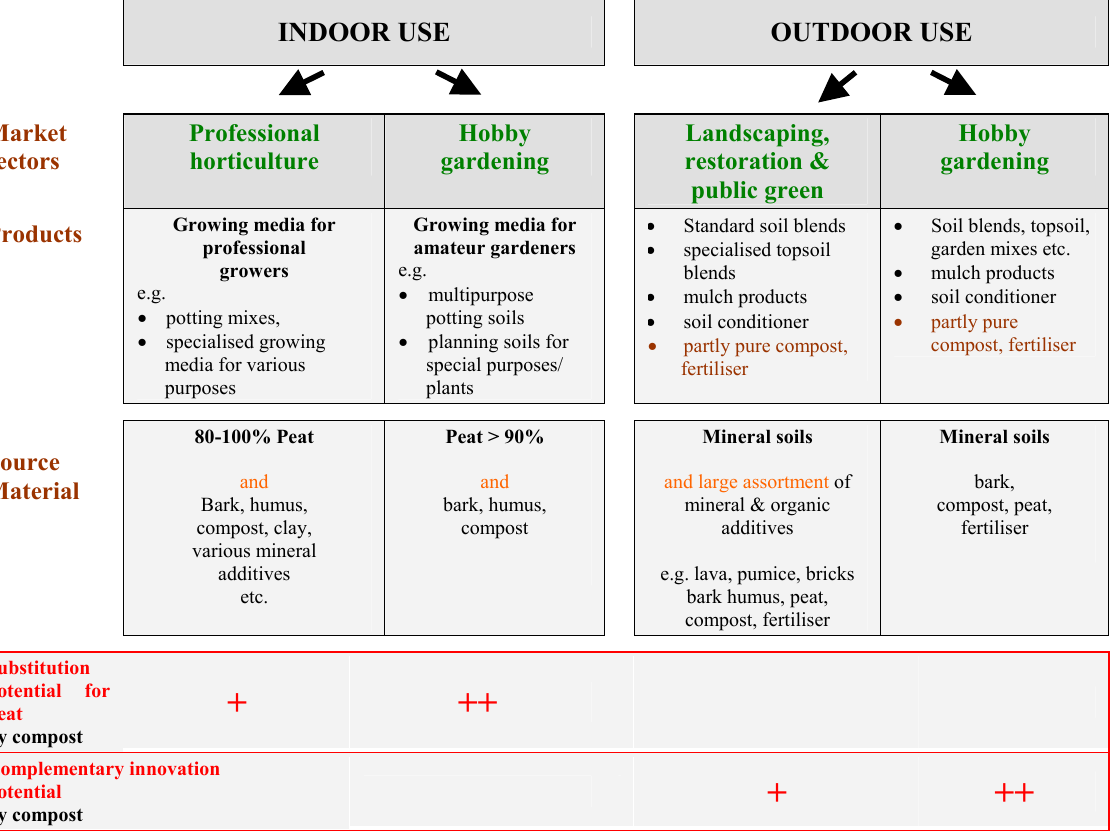
Figure 30: Relevant markets for humus products including compost (without agriculture and